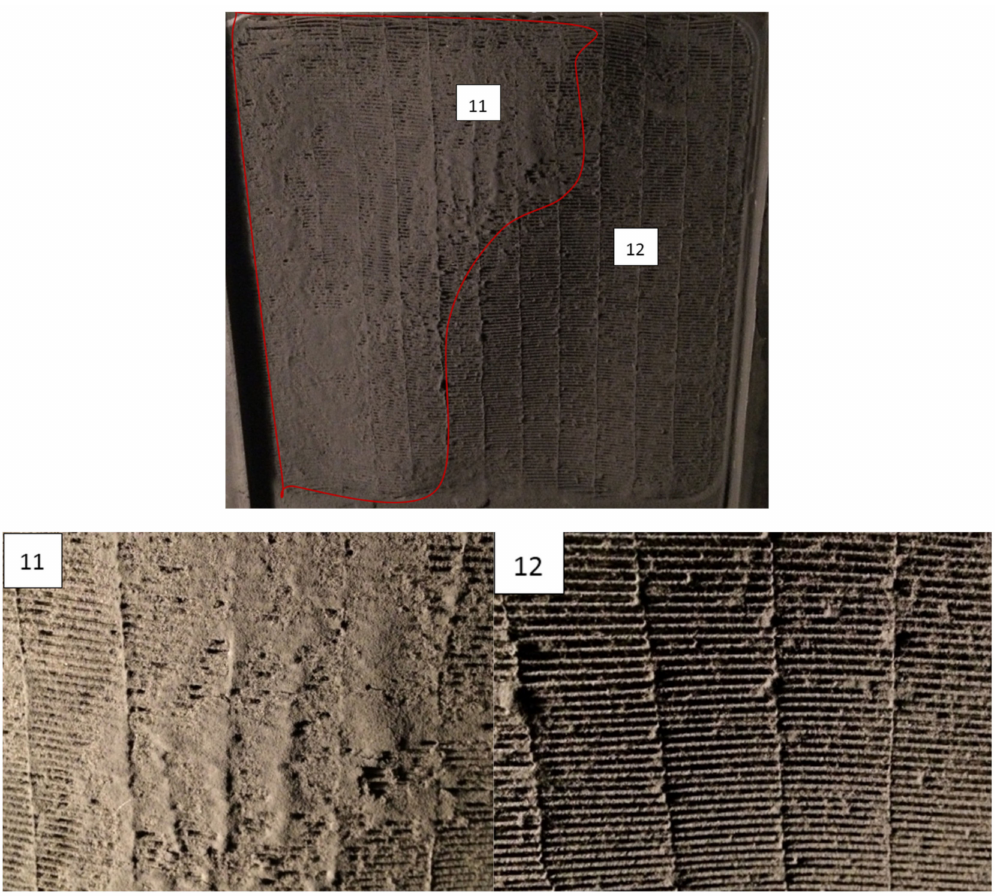
Figure 8. Heat exchanger surface after injection of 4000 g m − 2 of test dust at the end of measurement. Zone 11 consists of the fibers clogged by the dust, so air cannot flow through. In zone 12, there is a large deposit of the dust on the fibers, but there is no complete clogging of the heat transfer